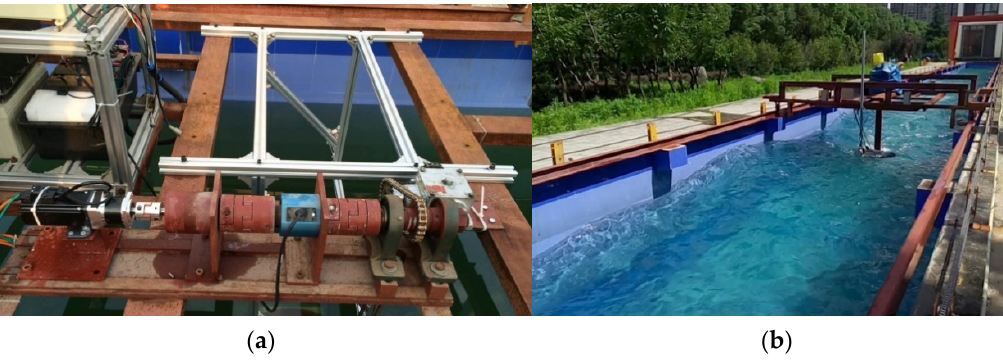
Figure 4. ( a ) Physical image of evaluation device, ( b ) The experimental pool.